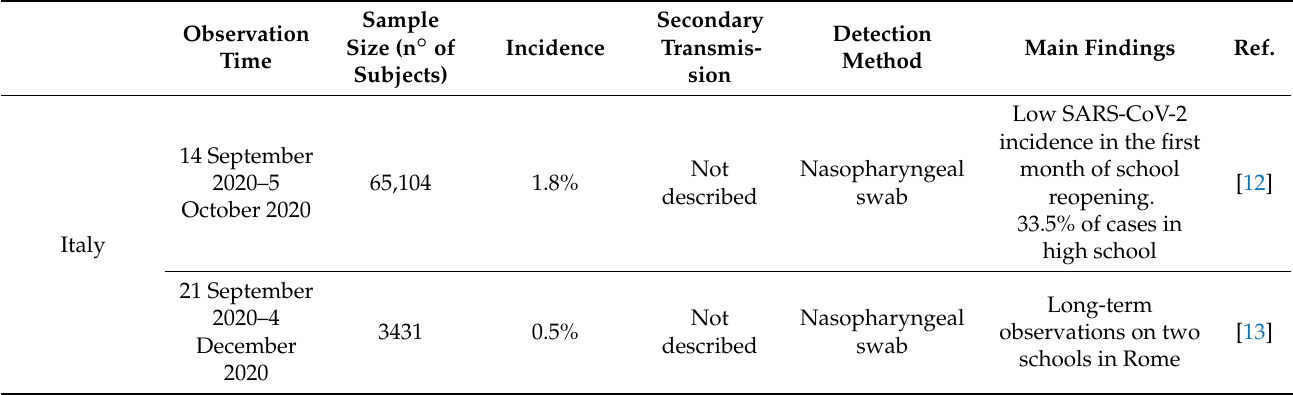
Table 1. Summary of the available studies investigating SARS-CoV-2 transmission in the school setting. Observation